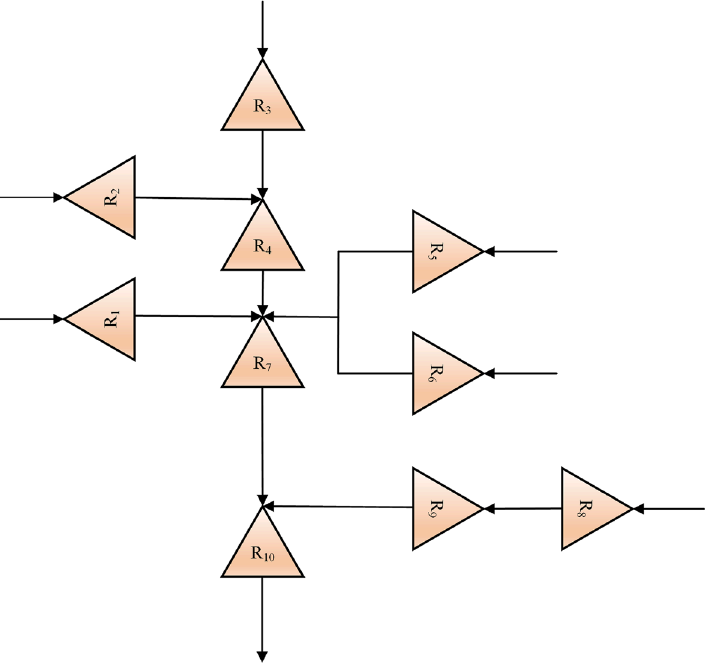
Figure 1. Schematic of ten-reservoir